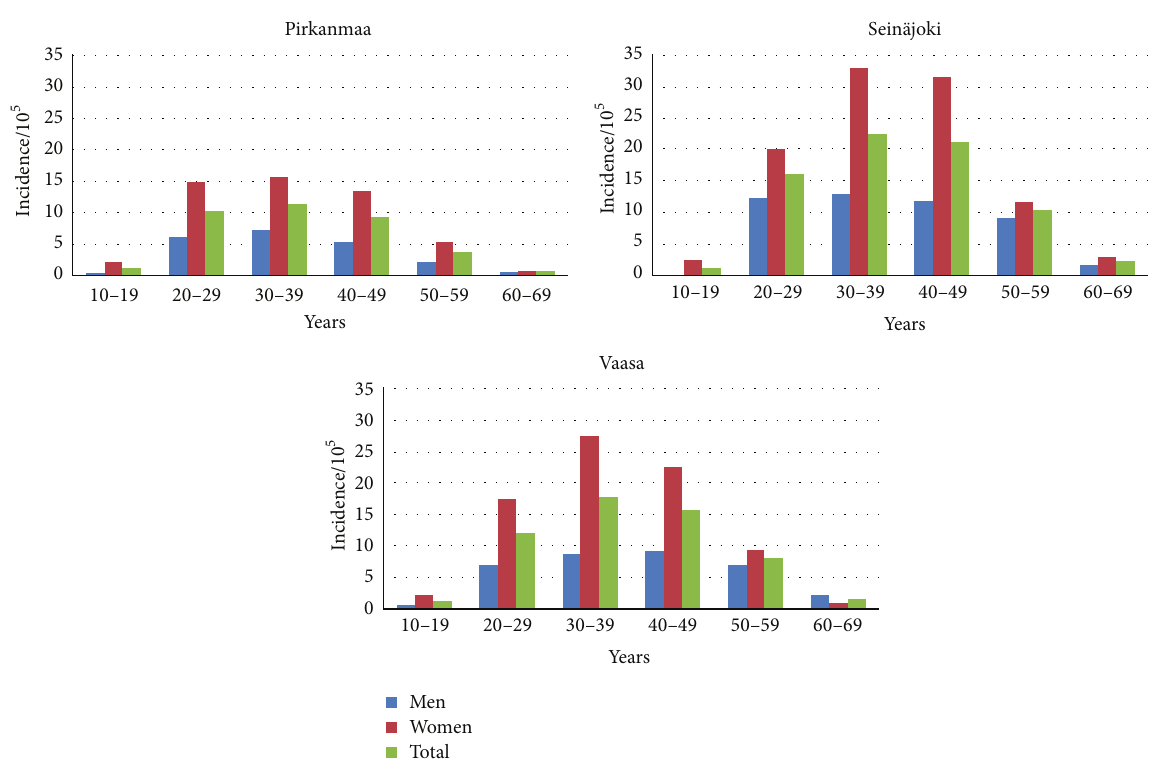
to this observation, the factors affecting males and females may be different in general, and some of these factors may act temporally and